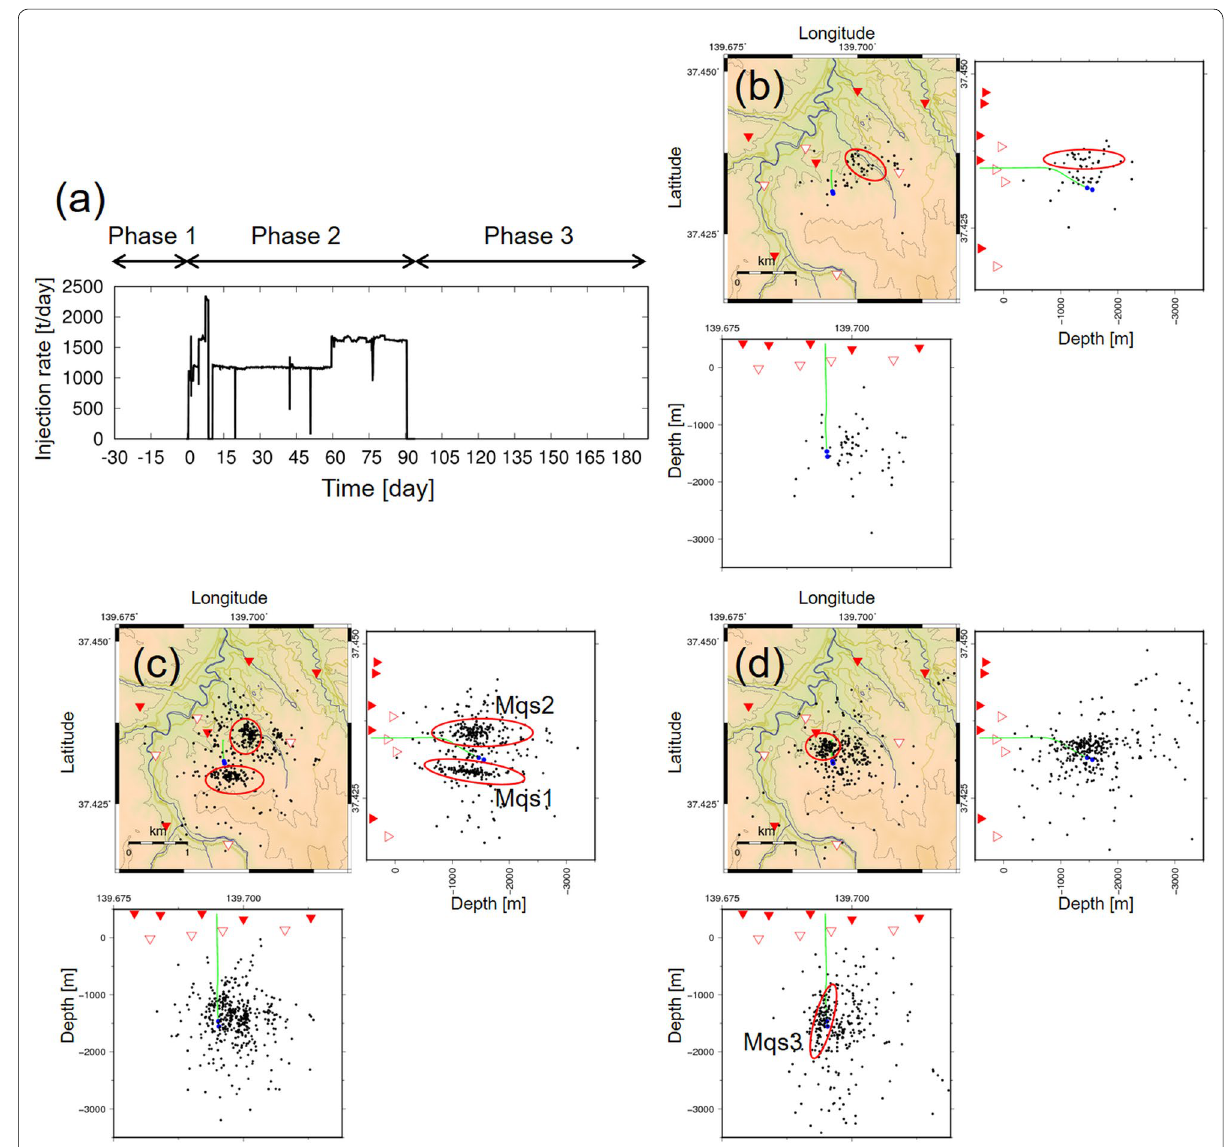
Fig. 1 Injection rate and hypocenter maps for microseismic events. a Injection rate of water. The horizontal axis shows the number of days from the start of injection; b – d hypocenter maps for b before the start of injection (Phase 1), c during injection (Phase 2), and d after the end of injection (Phase 3). The red and white triangles mark seismic stations on and below the surface, respectively. The green line shows the trace of the injected well (Test Well); the blue circles show the injection